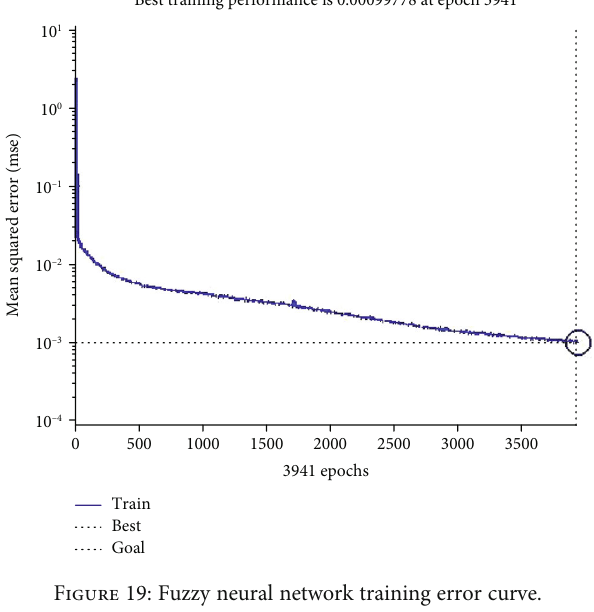
Table 5: Nondimensional treatment of learning date.